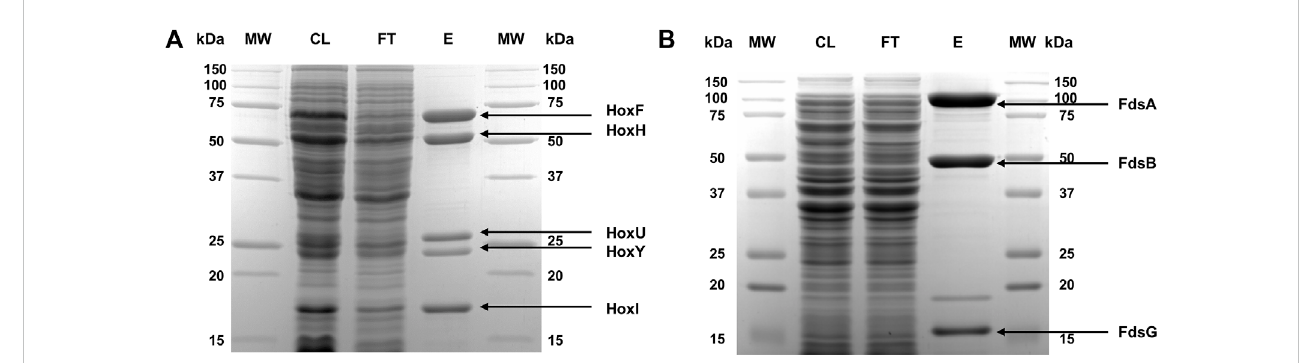
FIGURE 2 SDS-PAGE of puri fi ed proteins. (A) ReSH and (B) RcFDH stained with Coomassie blue. The lanes are molecular weight markers (MW), cell lysate after sonication (CL), fl ow-through streptavidin resin (FT), and eluted protein